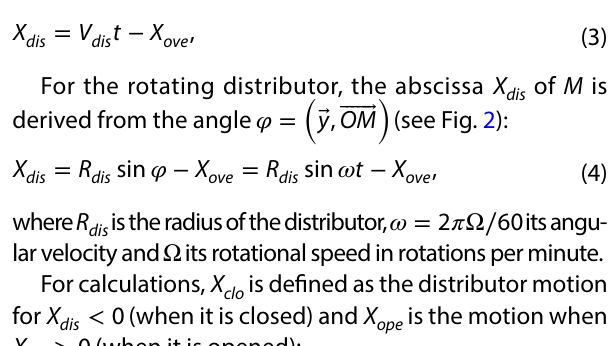
Fig. 2 Scheme of the rotating system a distributor opened, b distributor closed, c zoom at the overlap in case